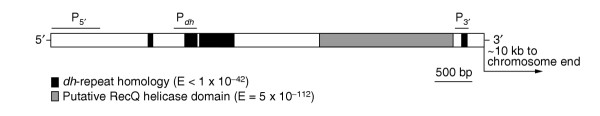
Homology of the putative helicase with RecQ helicases and dh repeats. The 5.6 kb sequence of SPAC212.11 is represented as a rectangle. Horizontal lines above the gene indicate the regions spanned by primers used in this study. P3' was the fragment of SPAC212.11 on the microarray (180 bases), and P5' was used in Southern hybridizations (642 bases). Region Pdh was amplified in RT-PCR experiments (Figure 7) to detect dh repeat forward and reverse strands. Solid black rectangles are regions of homology with dh repeats found at centromeres and in the K region of the mating-type locus. The predicted amino-acid sequence of the region marked with cross-hatching has homology with the RecQ helicase family. The BLAST expect (E) value is shown, with the exception that the approximately 70 bp region of homology to dh repeats 3' of the putative RecQ helicase domain has an E value of 2 × 10-8.